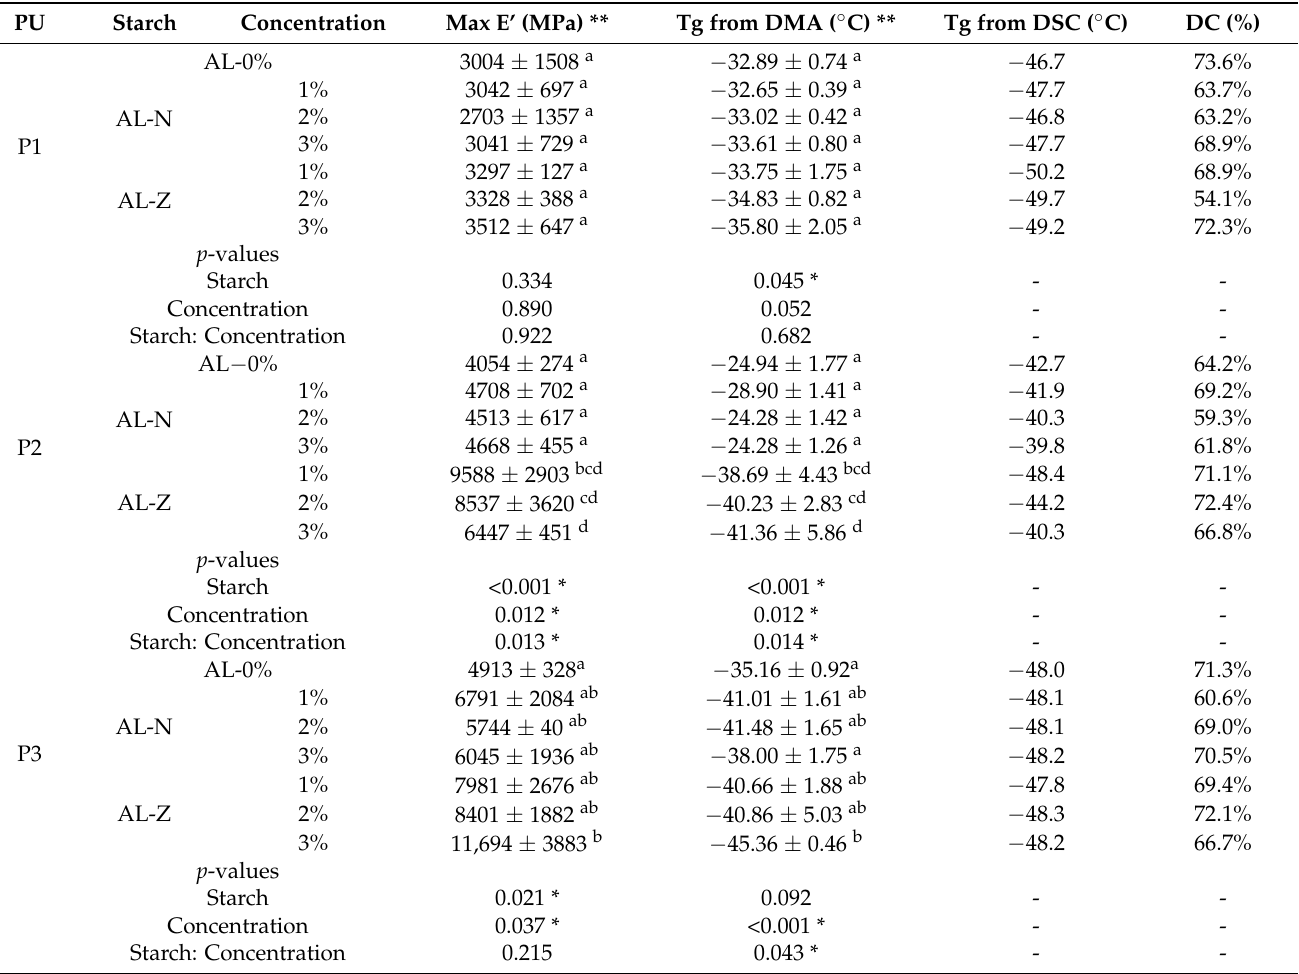
Table 3. Maximum storage modulus (Max E’), the glass transition temperature (Tg) from DMA and DSC, the degree of crystallinity (DC) of polyurethanes composite, and ANOVA